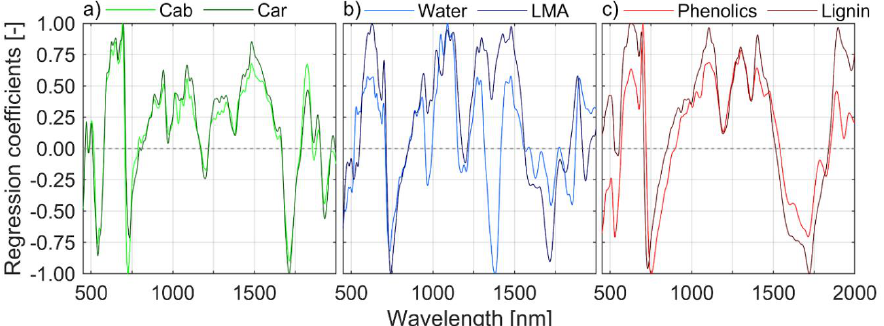
Figure 8. PLS regression coefficients weights for models (pooled NACs) of selected needle traits in spectral region 450– 2000 nm. ( a ) Cab—chlorophyll a+b content; Car—total carotenoids content. ( b ) Needle water content (area based), leaf mass per area. ( c ) Phenolics and lignin content. Ranges of the regression coefficients were normalized between −1 and 1.